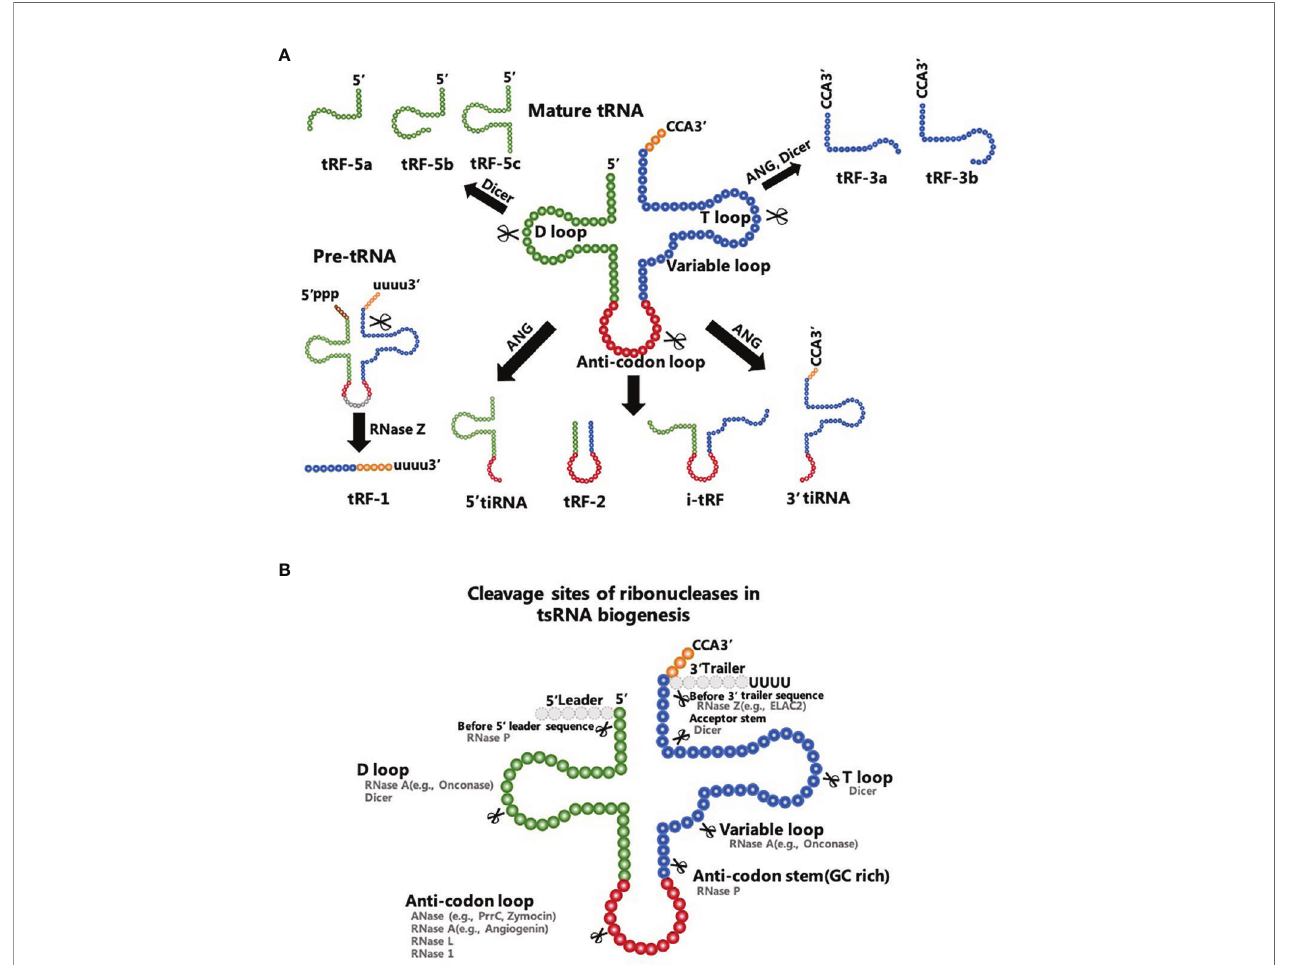
FIGURE 1 | Biogenesis and characteristics of tsRNAs. (A) tRF-1s are products of the RNase Z clipping off the 3 ’ -end of precursor tRNAs. tRF-5s are generated from the 5 ’ -tail of mature tRNAs to the D-loop or the sequence between the D-loop and the anti-codon loop of a mature tRNA. tRF-3s are derived from the T y C loop to the 3 ’ end of mature tRNAs. tRF-2s comprise the sequence straddling the anti-codon loop of mature tRNAs. i-tRFs comprise the anti-codon loop of mature tRNAs and sections of the D-loop and T-loop. (B) Ribonucleases in tsRNA biogenesis include Dicer, RNase P, RNase 1 and others with their known cleavage